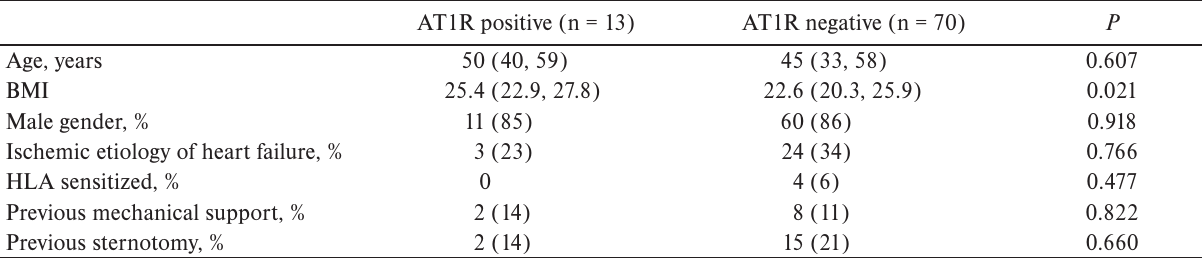
Table 1. Basic characteristics of AT1R antibody negative versus positive HeartMate II recipients before implantation.